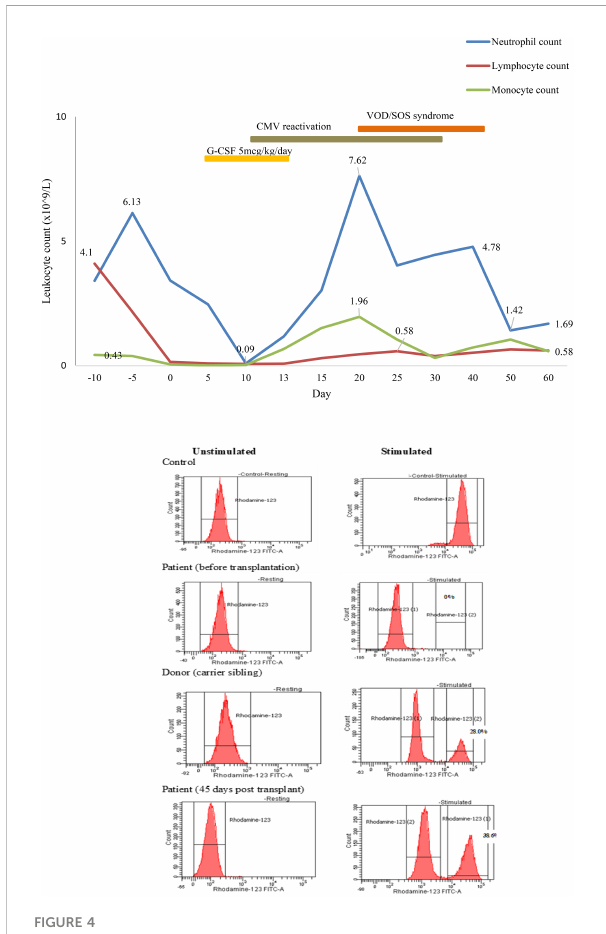
FIGURE 4 Engraftment of the neutrophil